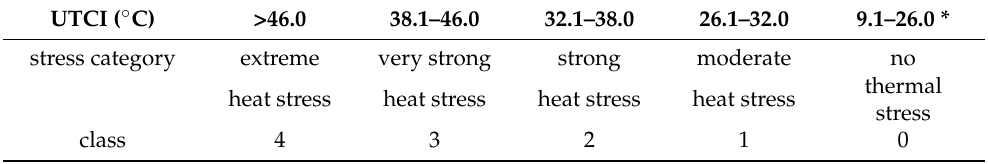
Table 2. Universal Thermal Climate Index (UTCI) threshold values regarding heat thermal stress [39].